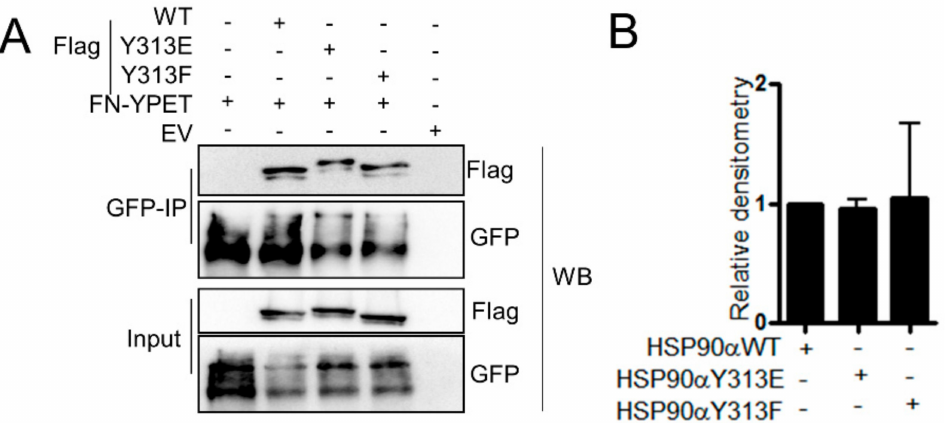
Figure 8. Mutation of HSP90-Y313 does not alter FN interaction. ( A ) Co-IP from HEK293T cells transfected with ( A ) pcDNA-Flag-90WT (WT), pcDNA-Flag-HSP90Y313E (Flag-Y313E; phosphomimetic), or pcDNA-Flag-HSP90Y313F (Flag-Y313F; phosphomutant) and ( B ) associated densitometry ( ± SD, n = 3) relative to wild-type HSP90. EV indicates empty vector